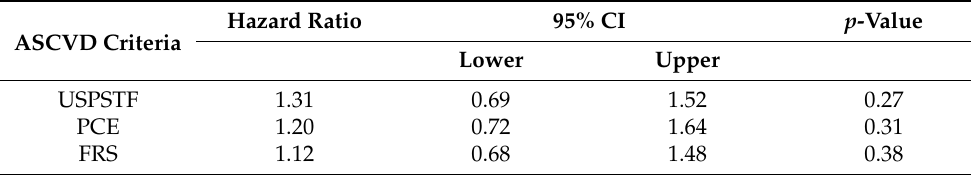
9 of 14 Table 6. Competing risk model (Fine–Grey Model), outcome—ASCVD event. ASCVD Criteria